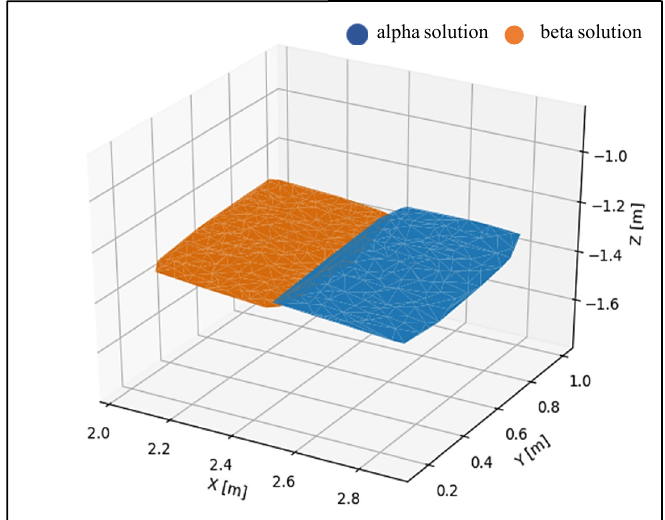
Figure 10 . Concrete pavement (Msplit fitting result).